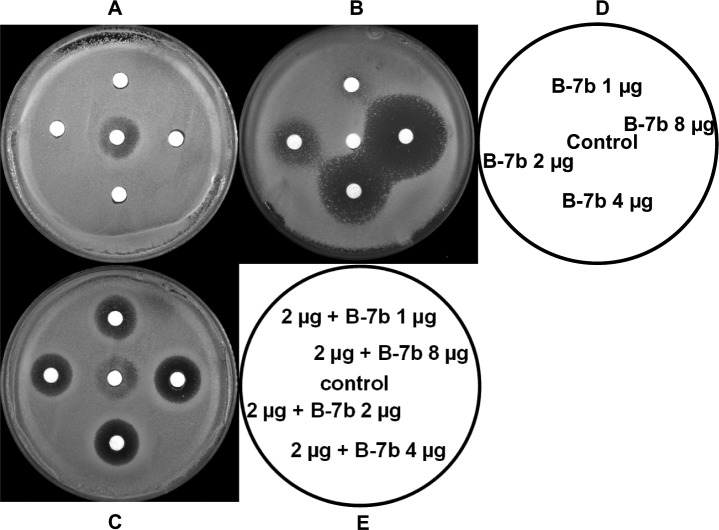
Agar disk diffusion assay of different concentrations of BBR derivatives combined with FLC against C. albicans 103.Agar disk diffusion assay of different concentrations of B-7b combined with FLC against C. albicans 103. Panels A and C show agar plates, and panel B shows an agar plate containing 4 μg/ml FLC. Panel D describes the images for panels A and B, which containing 1, 2, 4, 8 μg of B-7band 2 μg of FLC or just DMSO as control per disc. Panel E describes the image for panel C, the combination of B-7b (1, 2, 4, 8 μg) with FLC (2 μg) or FLC (2 μg) alone as control were contained in each disc.